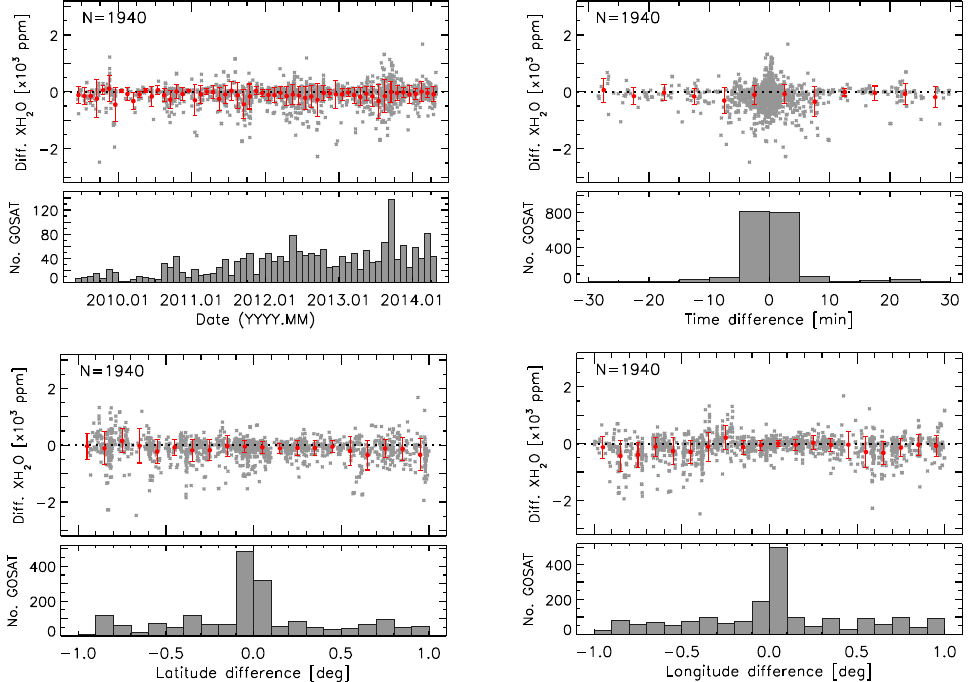
Figure 8. Correction of Figure 8 in [1]. Evolution of the XH 2 O absolute differences (GOSAT − TCCON) for the nominal coincidence criteria ( ± 1 ◦ latitude/longitude and ± 30 min) as a function of the measurement date (time series, top left panel) and of the collocation characteristics: time, latitude and longitude differences (top right, bottom left and bottom right panels, respectively). The corresponding histograms of the number of TANSO-FTS scans are plotted below each panel. The grey dots represent the single-scan differences; the red symbols with “error bars” show the average value and associated standard deviation within each histogram bin.